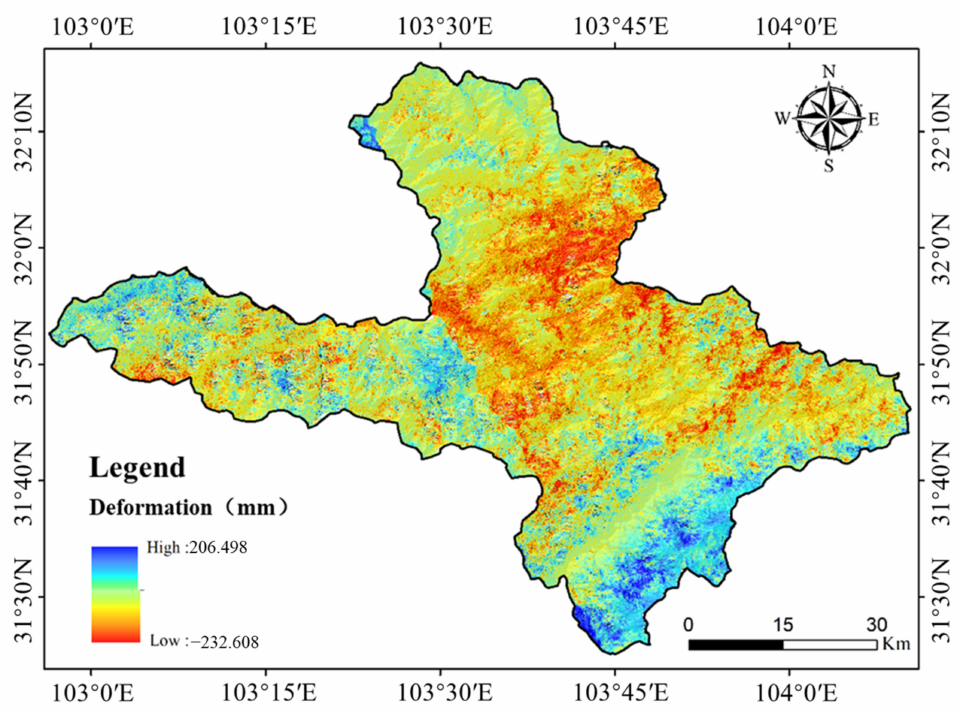
Figure 8. Deformation of slope direction in the study area.